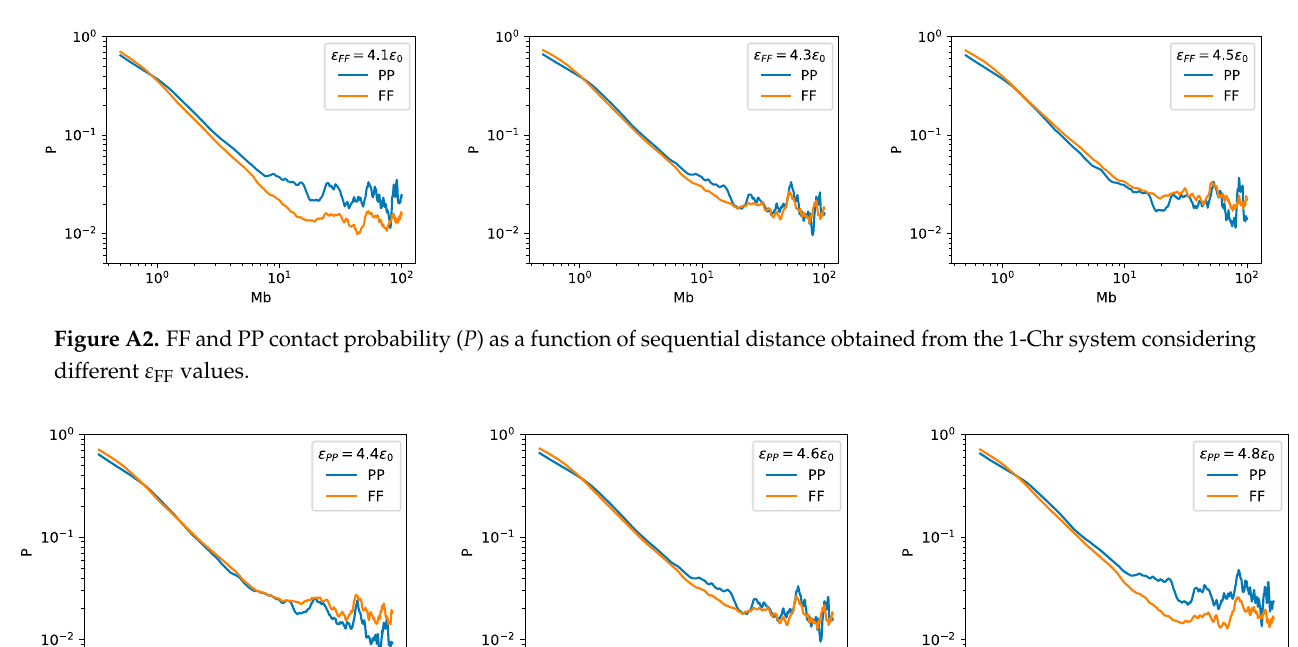
Figure A1. The RDFs obtained from the 1-Chr system with different ε PB values.